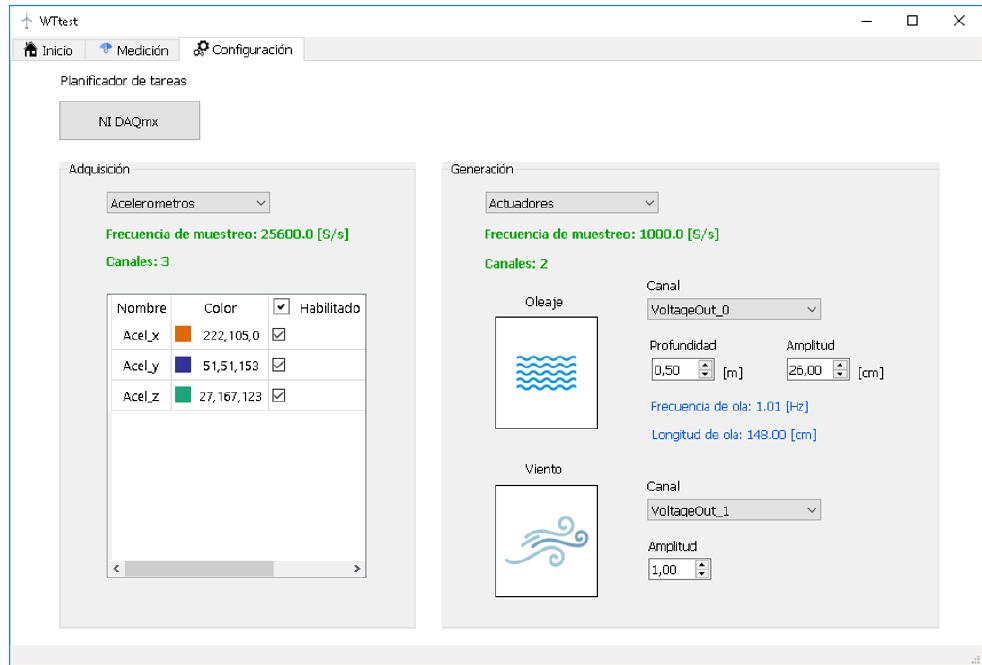
Figure 10. Configuration tab for DAQ